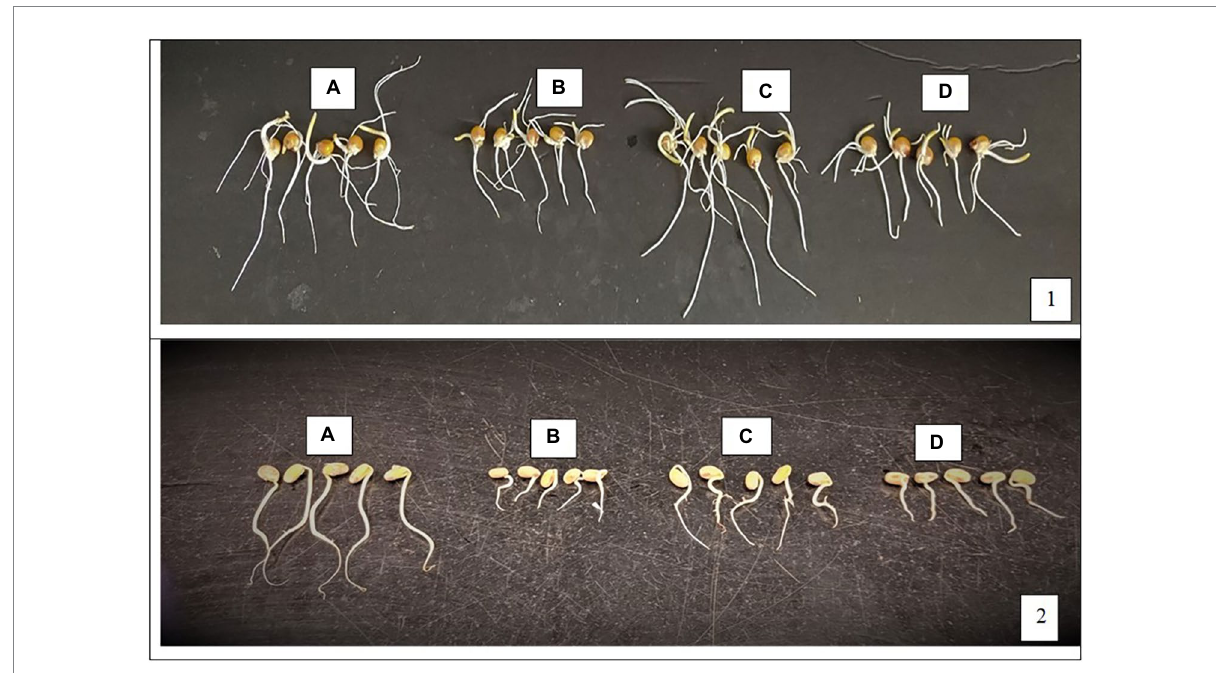
FIGURE 2 Effect of treatments on germination and radicle length of corn (1) and soybean (2). From left to right: 0 mM NaCl (A) , 100 mM NaCl (B) , 100 mM NaCl +0.2% EL2006H (C) and 100 mM NaCl +0.2% MRS (D)